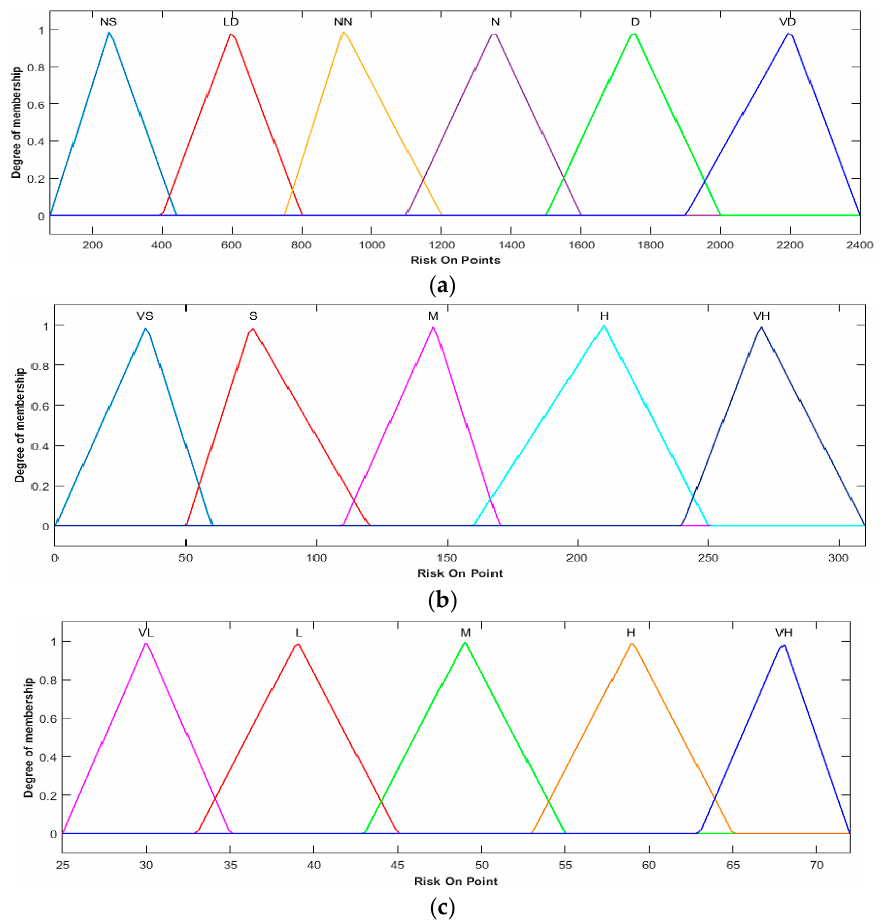
Figure 10. Input/output membership functions for P1_FIS. ( a ) Input depth; ( b ) input length; and ( c ) output partial 1 risk index. and ( c ) output partial 1 risk